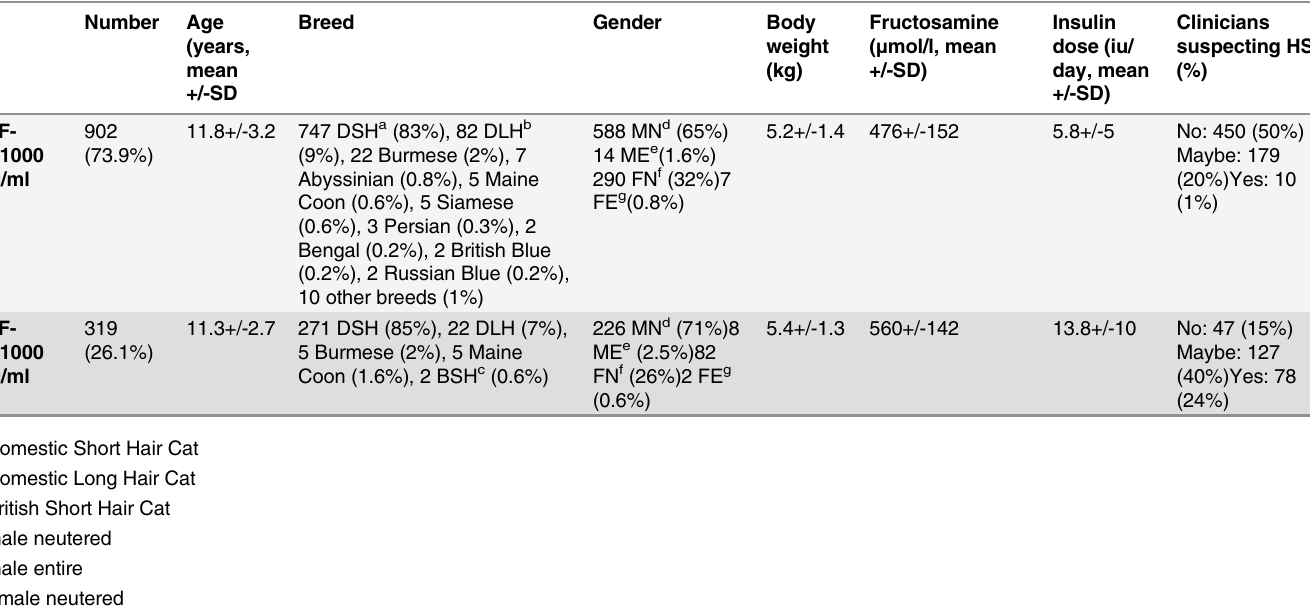
Table 1. Table comparing basic characteristics of diabetic cats with excessively high ( > 1000ng/ml) and low ( < 1000 ng/ml) serum total insulin-like growth factor-1 (IGF-1)